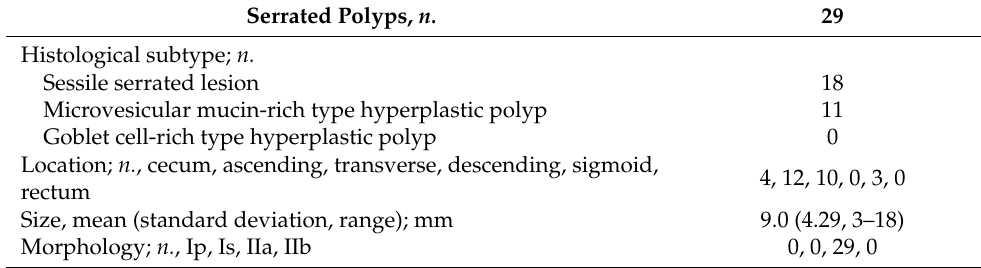
Table 1. Clinicopathological characteristics of patients and adenomas.